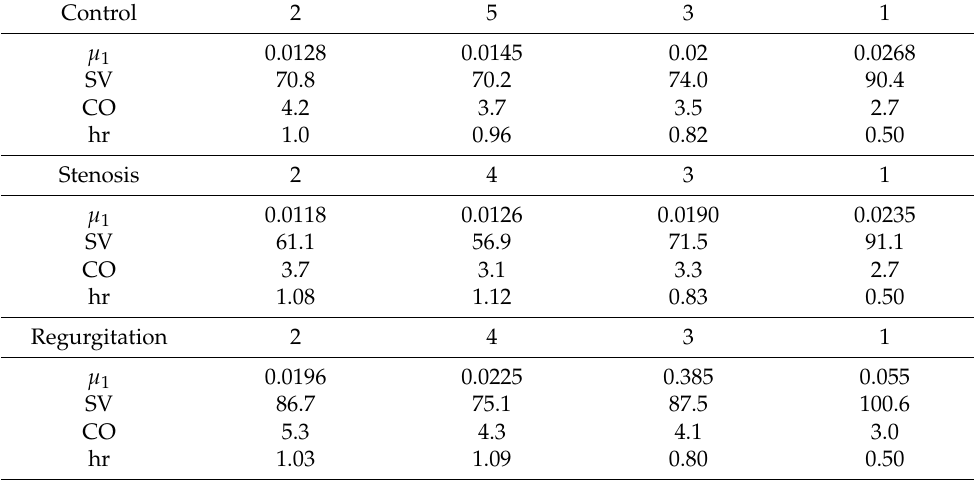
Table 5. Effect of µ 1 with a severe mitral valve stenosis or regurgitation. Refer to Table 4 for severity. µ 1 increases from left to right. The headings 2, 4 or 5, 3, and 1 denote the number of P-V loops appearing in the P-V plot as µ 1 is increased. The results given in the µ 1 rows give the values of µ 1 at which the 2, 4 or 5, 3, and 1 P-V loops are observed. SV, CO, and hr rows likewise provide the stroke-volume, cardiac output, and heart rate measured at that value of µ 1 .